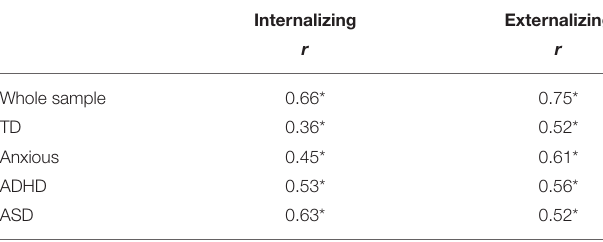
TABLE 2 | Correlations with emotion regulation by group.